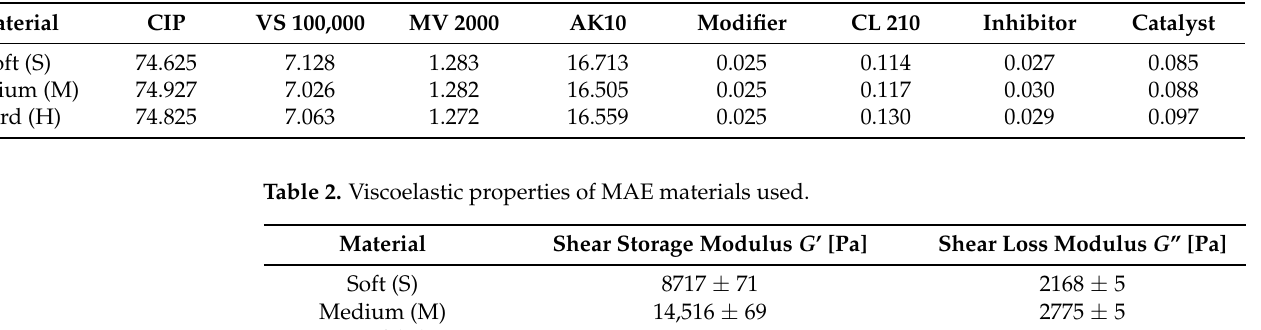
Table 1. Proportions of individual components for fabrication of MAE samples in wt.%.